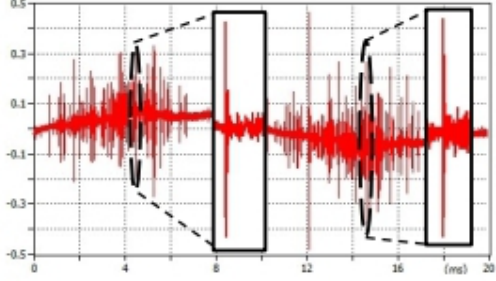
Figure 5. Visualization of false-hit pulses